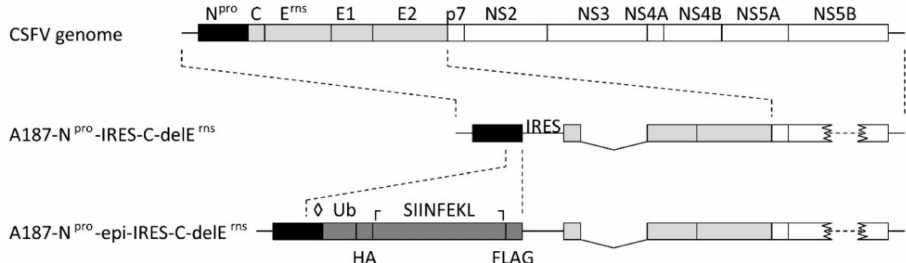
Figure 2. Design of the backbone replicon A187-N pro -epi-IRES-C-delE rns . The map of the backbone replicon (packaged in VRP 0) used in this study is represented schematically, with the N pro gene shown in black, the structural protein sequences in light gray, and the non-structural protein region in white. The cassette for ubiquitinated and tagged epitope expression is shown in dark gray and encodes a non-cleavable ubiquitin (Ub), a haemaglutinin tag (HA), an epitope site, and a FLAG tag. Additionally, a C 138 A mutation was introduced in N pro to destroy the N pro -mediated interferon regulatory factor 3 degradation ( ♦ ), and the sequence coding for the SIINFEKL control epitope was flanked by an upstream Kas I restriction site ) and a downstream Mlu I restriction site ( ) for replacement of the SIINFEKL sequence with the porcine reproductive and respiratory syndrome virus (PRRSV) polyepitope